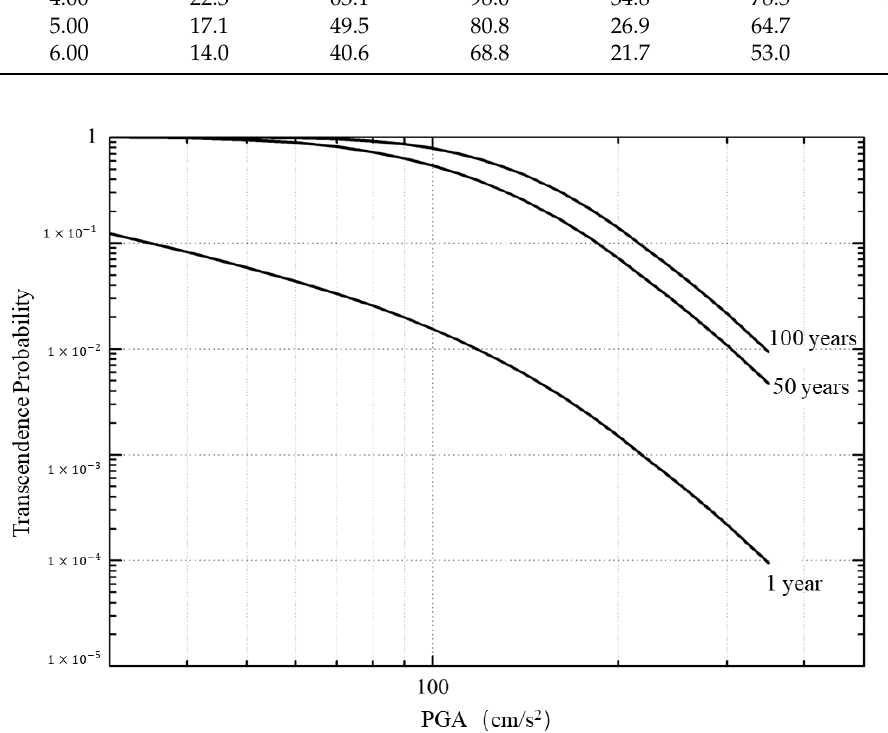
Figure 3. Transcendence probability curve of the horizontal peak acceleration of bedrock at the engineering site of Najin Lhasa.